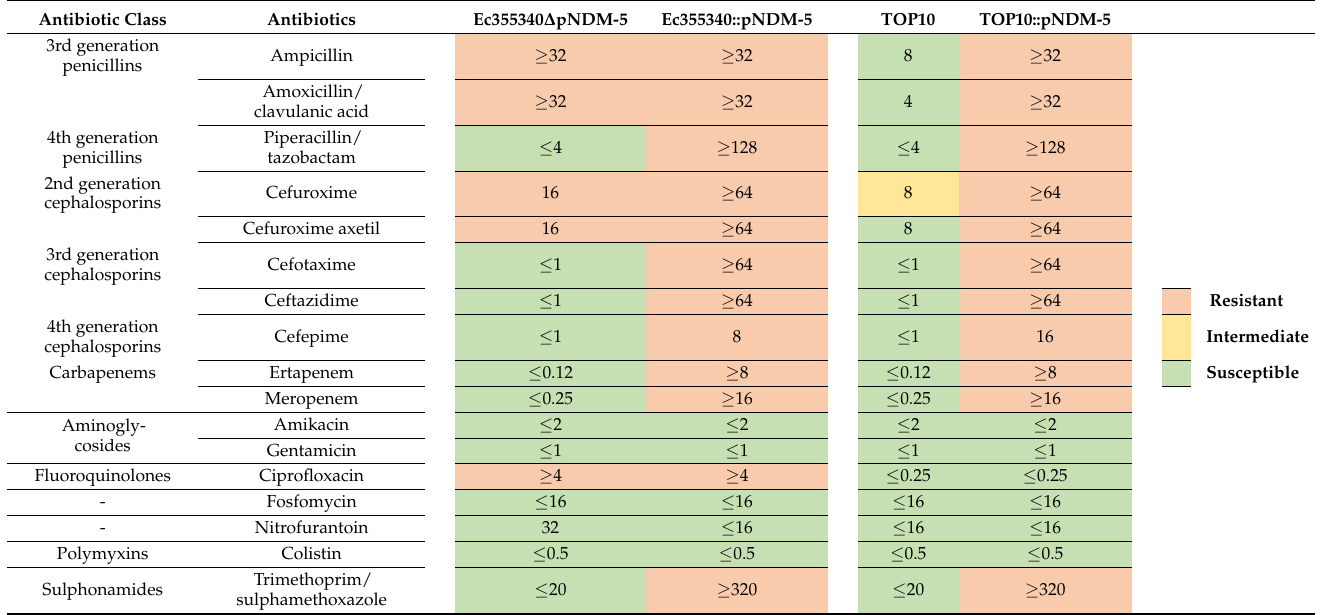
Table 1. Minimum inhibitory concentrations determined by VITEK ® 2 for the clinical strain identified in this study (Ec355340::pNDM-5), the plasmid-cured strain (Ec355340 ∆ pNDM-5), the transformant (TOP10::pNDM-5) and the recipient electrocompetent cells